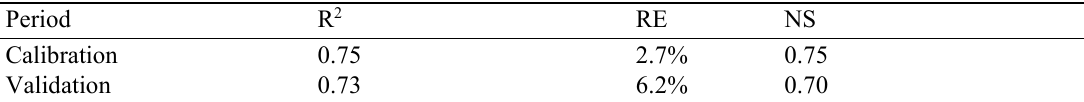
Table 3 Statistics of model calibration and